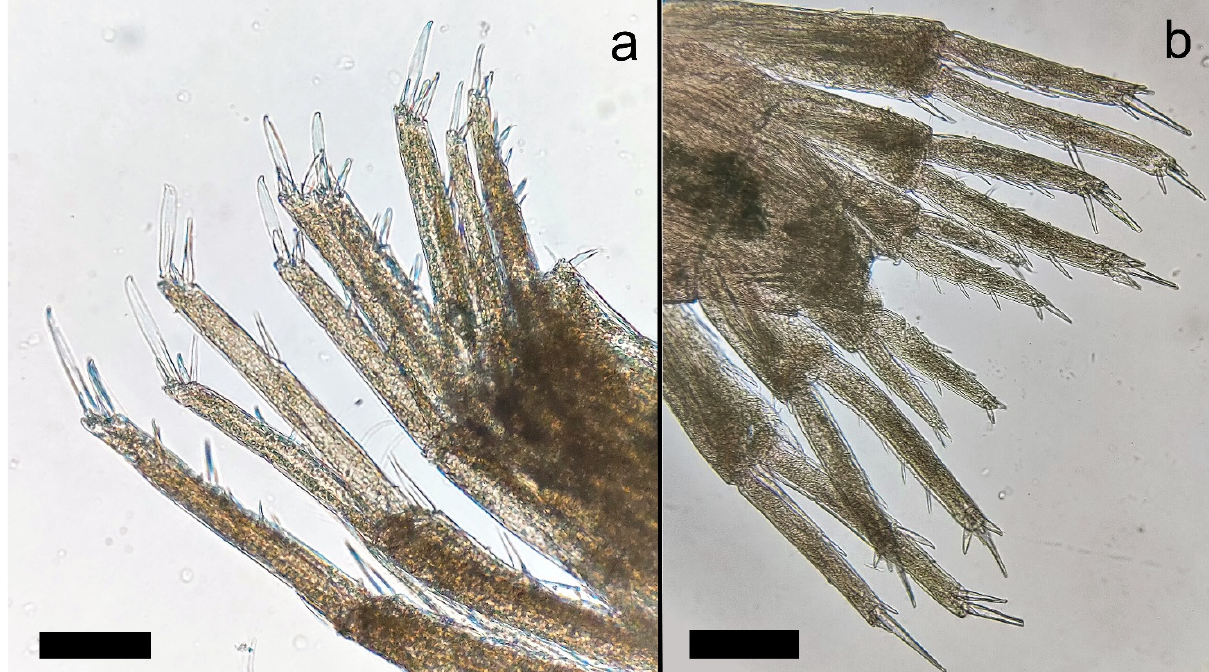
Figure 7. Megamphosus katagani : ( a ) lateral view of urosome ( b ). dorsal view of urosome. Scale bar for all the pictures: 0.1 mm. Photo credit: Emanuele Mancini.